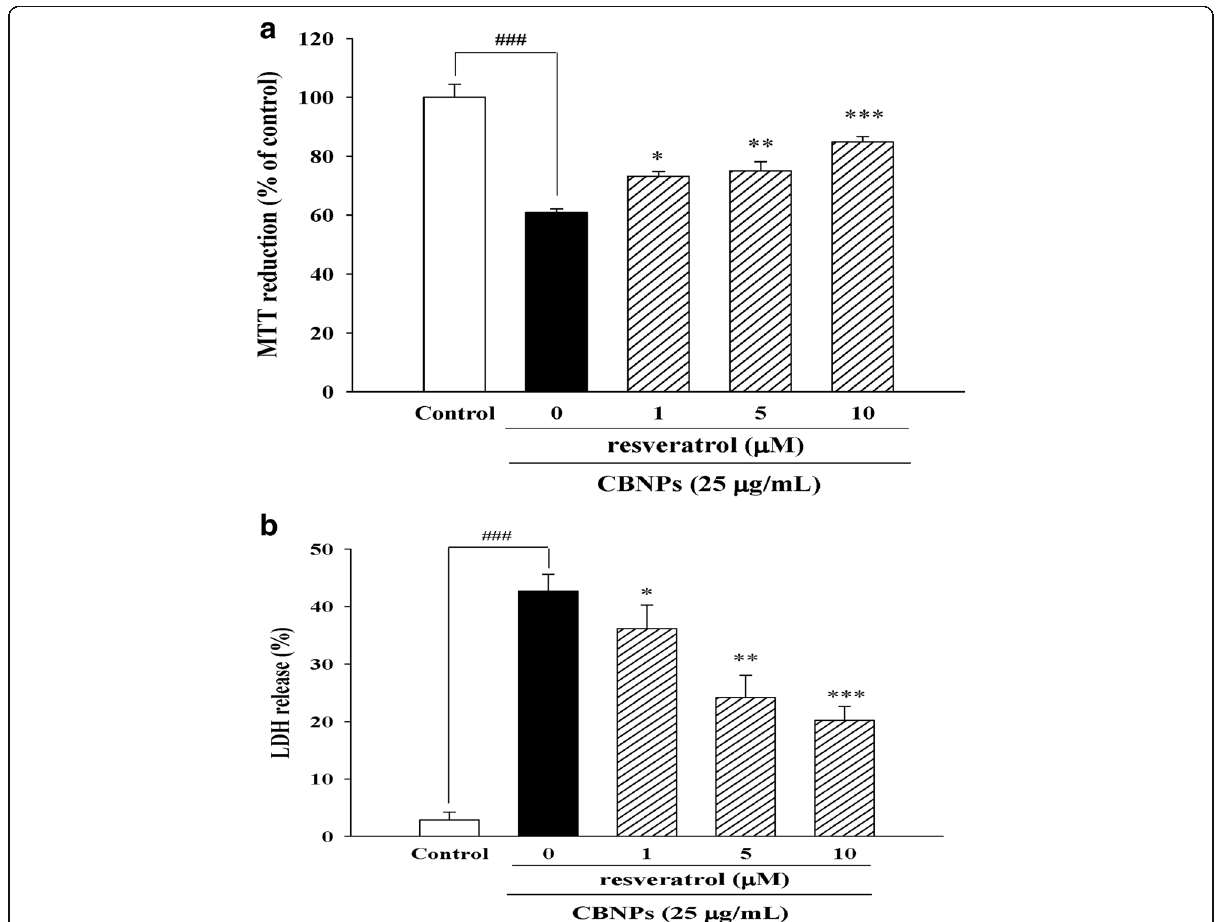
Fig. 6 Effects of resveratrol on cell viability in CBNPs-treated A549 cells. Cells were pre-treated with resveratrol for 1 h before addition of CBNPs (25 μ g/mL) for 24 h. Cell viability was measured by MTT ( a ) and LDH assay ( b ). Bars represent the mean ± S.E.M. from six independent experiments. ### P < 0.001 vs. control group (without any treatment). * P < 0.05, ** P < 0.01, *** P < 0.001 vs. CBNPs (25 μ g/mL)